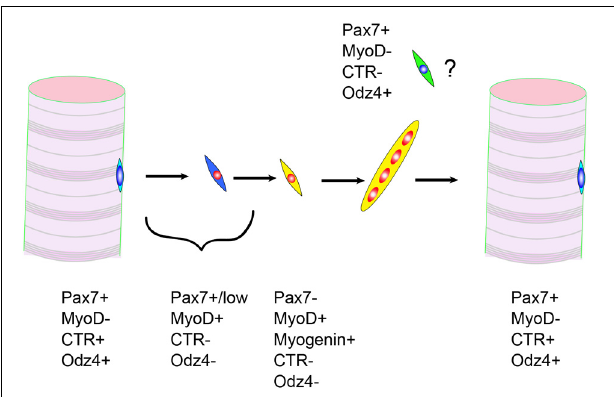
FIGURE 2 | Expressions of calcitonin receptor (CTR) and Odz4 proteins during skeletal muscle regeneration. Pax7 + MyoD-CTR-Odz4 + cells are frequently observed during myofiber